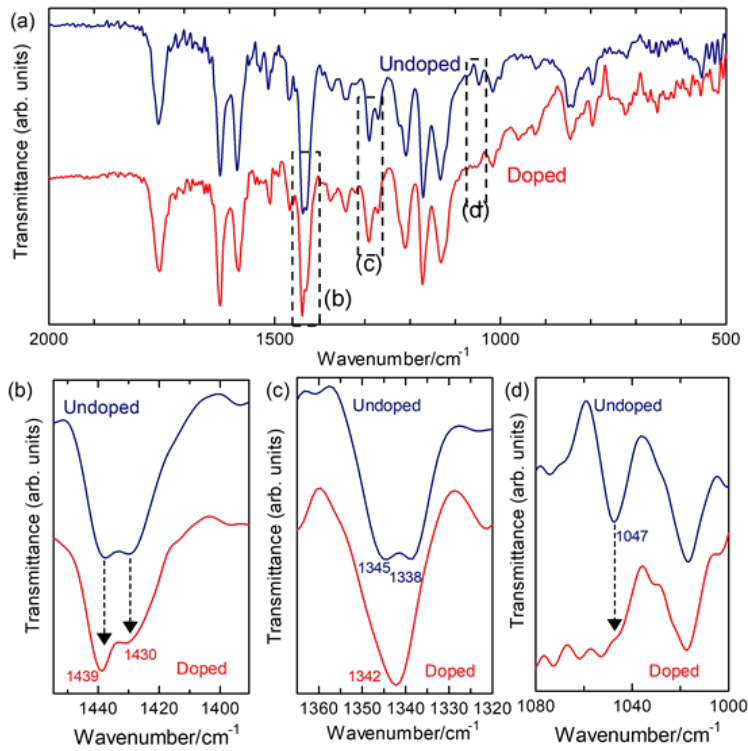
Figure 13. IR absorption spectra of poly(Ac–Pyr). ( a ) IR absorption of poly(Ac–Pyr) before and after iodine doping. ( b – d ) Magnification of the IR absorption spectra of poly(Ac–Pyr) before and after iodine doping.